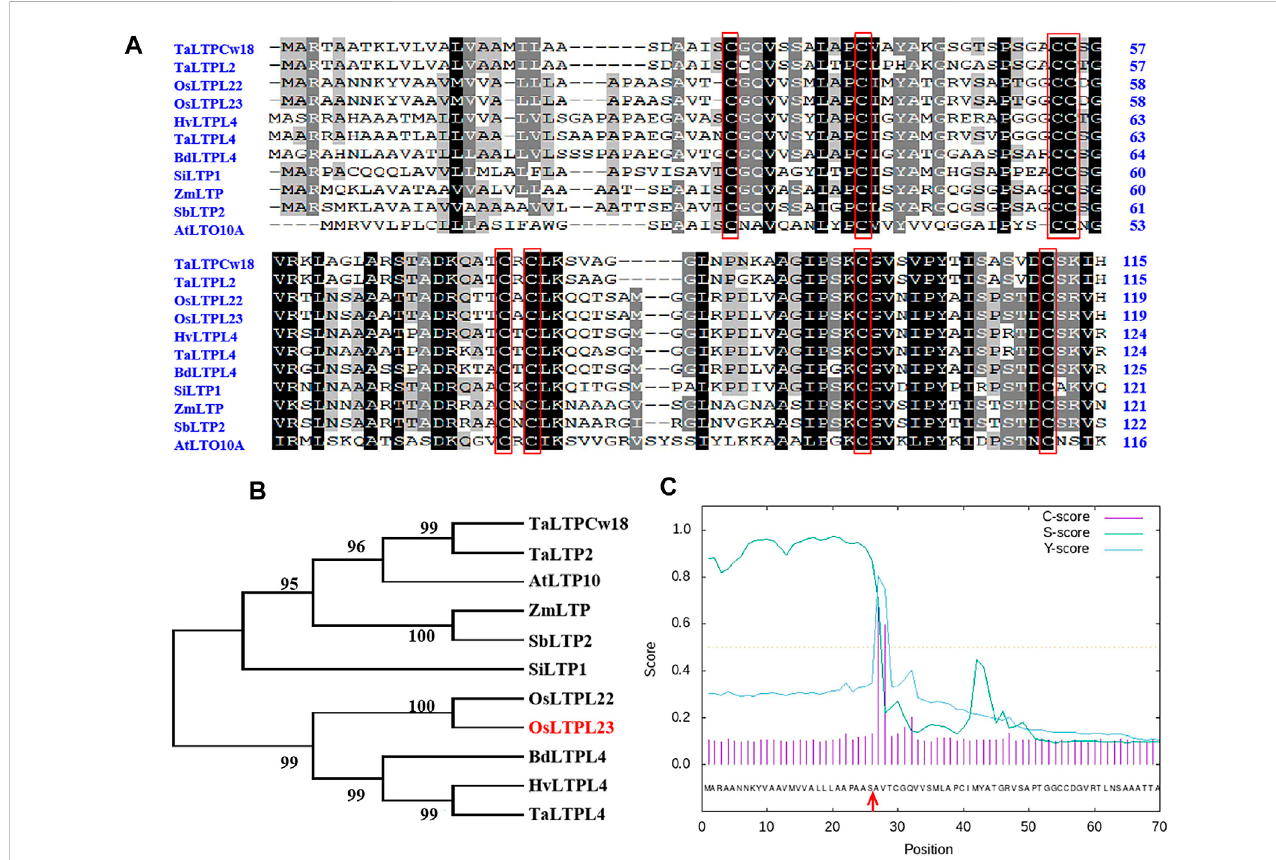
FIGURE 2 Sequence analysis of OsLTPL23 protein. (A) Primary sequence alignment of OsLTPL23 with homologues. Conserved eight-cysteine motif are represented by red rectangles. (B) Phylogenetic tree of OsLTPL23. Ta, Triticum aestivum ; At, Arabidopsis thaliana ; Zm, Zea mays ; Sb, Sorghum bicolor ; Si, Setaria italica ; Os, Oryza sativa ; Bd, Brachypodium distachyon ; Hv, Hordeum vulgare . (C) Signal peptide prediction of OsLTPL23. The red arrows indicate the predicted signal peptide cleavage site using SignalP4.1 (https://services.healthtech.dtu.dk/service.php?SignalP-4.1).